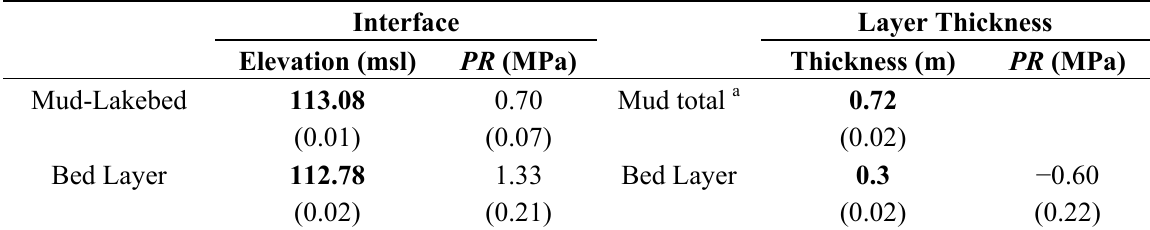
Table 2. Mean interface elevation (msl) and mean layer thickness (m) indicated by changes in PR to delineate the lake bed surface and shallow lake bed sediment layers in point